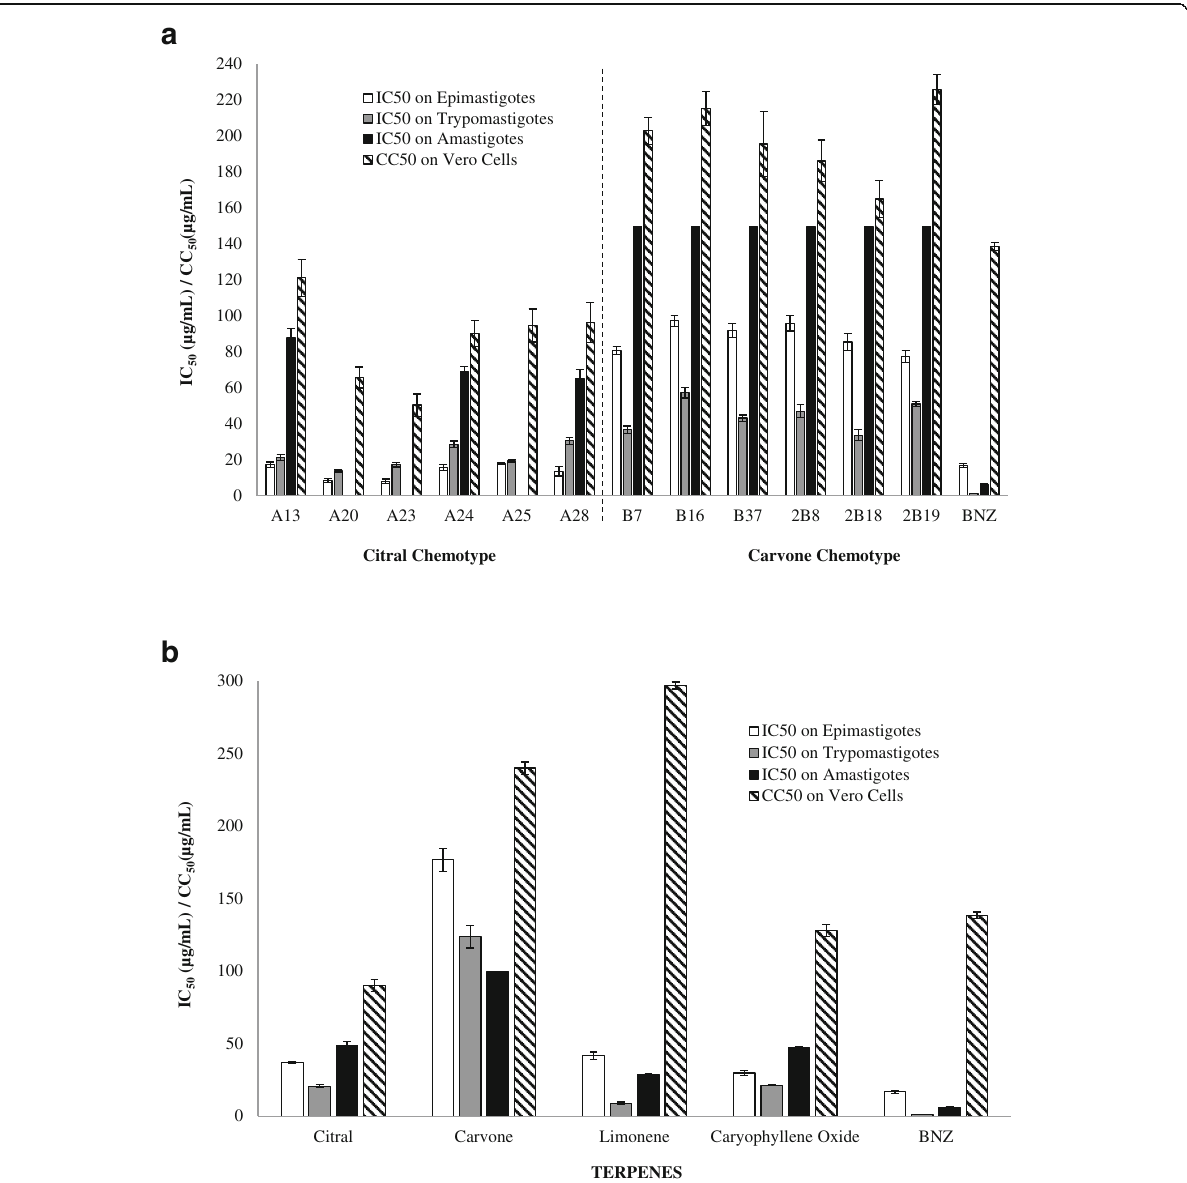
Fig. 2 In vitro trypanocidal and cytotoxic activity of Citral and Carvone chemotype L. alba essential oils ( a ) and their bioactive terpenes ( b ) on cyclic forms of Trypanosoma cruzi . IC 50 : Inhibitory Concentration 50 on T. cruzi ; CC 50 : Cytotoxic Concentration 50 on Vero Cells